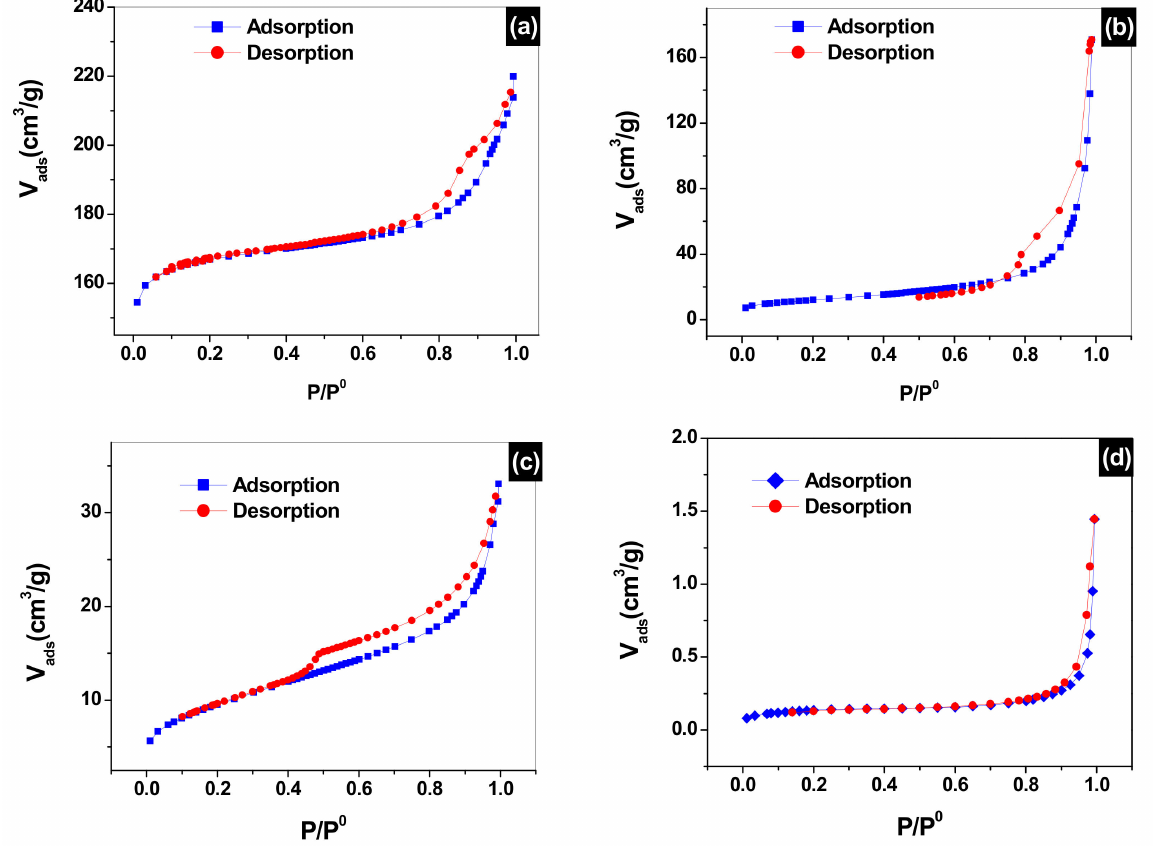
Figure 4. N 2 adsorption/desorption isotherms of ( a ) faujasite, ( b ) sodalite, ( c ) raw clay mineral and ( d ) 160 µ m ≤ Φ ≤ 250 µ m support sintered at 1000 ◦